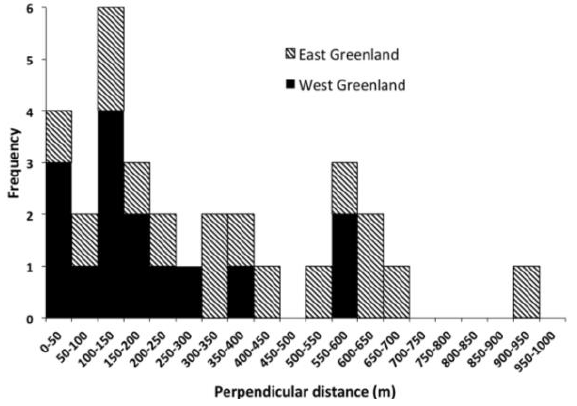
Figure 4. Distribution of sightings of minke whales in East and West Greenland in 2015 (n=31) in sea states <3. All minke whale detections were of single individuals and the explanatory variables available to be included in the MRDS models were a) perpendicular distance to sightings, b) sea state, and c) observer. Effort and sightings made in sea state above 2 were excluded from the model (Figure 3). Estimates of correction factors for perception bias were developed for both MRDS methods and by the Chapman estimator for the strip census estimates (Table